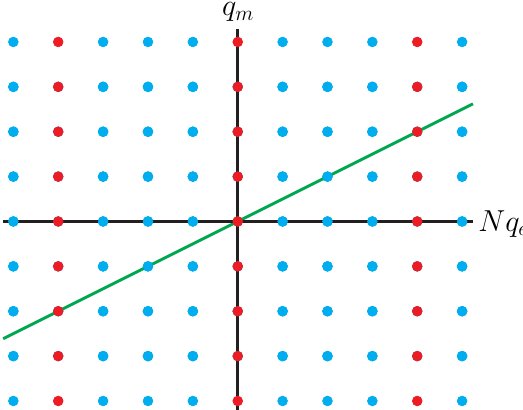
Figure 2: Charge lattice for the example of (cid:90) ing possible electric charges, Nq denote dynamical charges in the UV theory, and the blue dots represent the left over “static” probes. When a dyon with charges ( q that lie along the green line are deconfined, and all others are